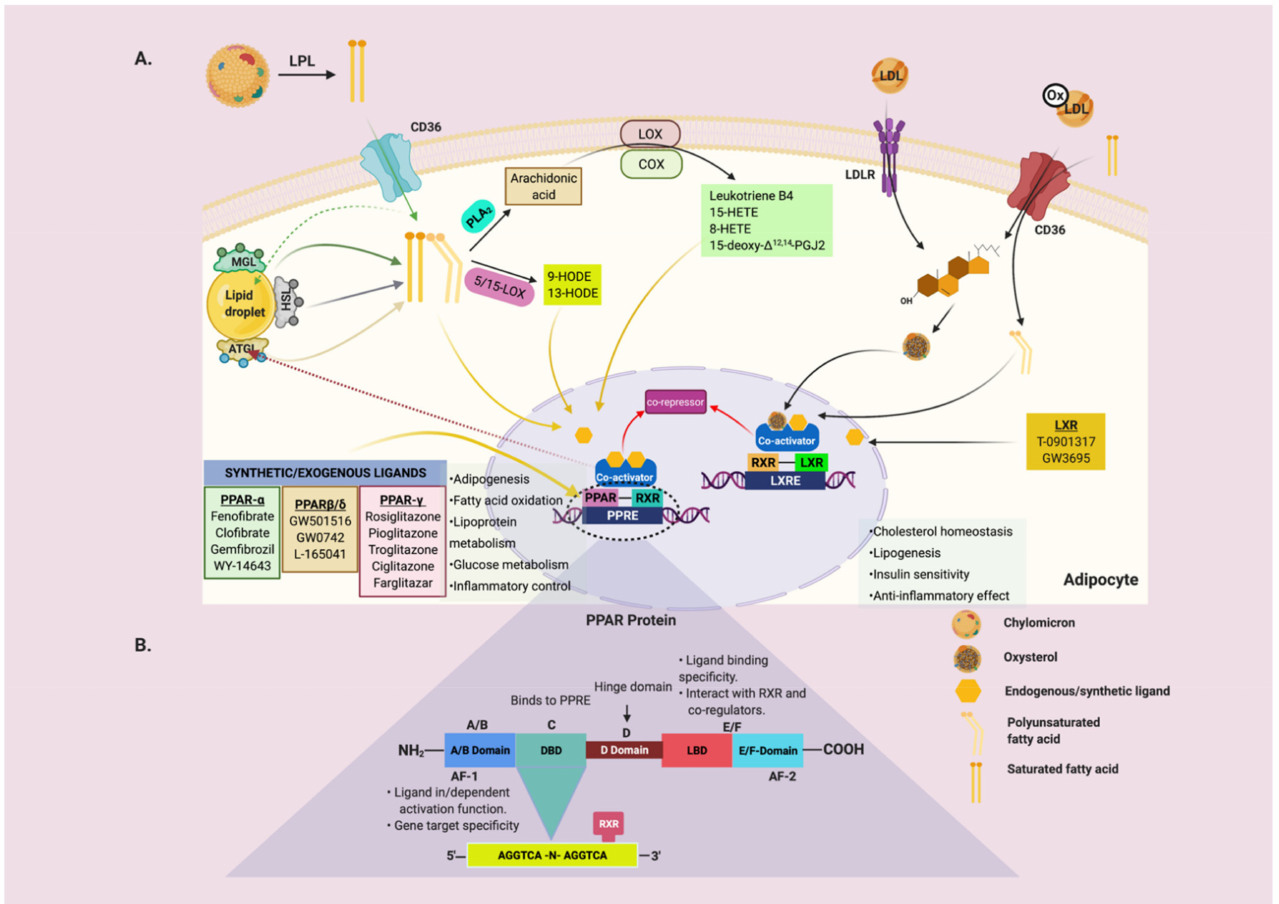
Figure 1. ( A ) General mechanisms of the interdependency between lipid sensing nuclear receptors and metabolic lipases. Dietary FAs are re-esterified into TAG and secreted as part of chylomicron. Plasma chylomicron undergoes rapid hydrolytic activities by LPL. The FAs produced are taken up by the adipose tissues and other underlying tissues via the FAs transporter, CD36. The assimilated FAs are either stored in lipid droplets, undergo oxidation, or as ligands for the lipid sensing nuclear receptors, such as PPARs and LXR. When required, the lipid droplets release FAs through the catabolic actions of ATGL regulated by PPAR γ . The FAs and their enzymatically derived derivatives, such as 15-HETE, 8-HETE, 15d-PGJ2, 9-HODE, 13-HODE, LTB4, and exogenous ligands, are potent endogenous ligands for the PPARs. Oxysterols are ligands for LXR/RXR. The liganded PPAR/RXR heterodimer causes a conformational change that leads to the displacement of the corepressor and recruits’ coactivators to drive transcriptional activities. ( B ) Schematic representation of the PPAR: The PPAR structure comprises six domains, namely A/B, DBD, D-domain, LBD, and E/F domain. When PPAR is liganded and heterodimerizes with RXR, these domains integrate intracellular signals to direct the transcriptional activity of multiple target genes through their PPRE that harbors in their promoter regions. Abbreviations: ATGL: adipose triglyceride lipase, AF-1/2: activating factor 1, 2, COX: cyclooxygenase, DBD: DNA-binding domain, FFA: free fatty acids, HETE: hydroxyeicosatetraenoic acid, HODE: hydroxyoctadeca-9Z,11E-dienoic acids, HSL: hormone-sensitive lipase, LBD: ligand-binding domain, LOX: lipoxygenase, LPL: lipoprotein lipase, LTB4: leukotriene B4, LXR: liver X receptor, MGL: monoglyceride lipase, PPAR: peroxisome proliferator-activated receptor, PPRE: PPAR response element, 15d-PGJ2:15-deoxy- ∆ 12,14-prostaglandin J2, RXR: retinoid X receptor. Created with BioRender.com, accessed on 16 March 2021. Transcriptional regulation by PPAR/RXR heterodimers depends on binding a cognate PPAR or RXR ligand [10]. Indeed, ligand-activated PPAR/RXR undergoes a conformational change that catalyzes the displacement of corepressors and recruits co-factors to the pro- moter region of the targeted genes to initiate transcription (Figure 1A). The typical endoge- nous ligand for PPARs are FAs and their derivatives like the eicosanoids, prostaglandins, and leukotriene B4 (Table 1) (reviewed in ([5]). Several synthetic PPAR ligands also